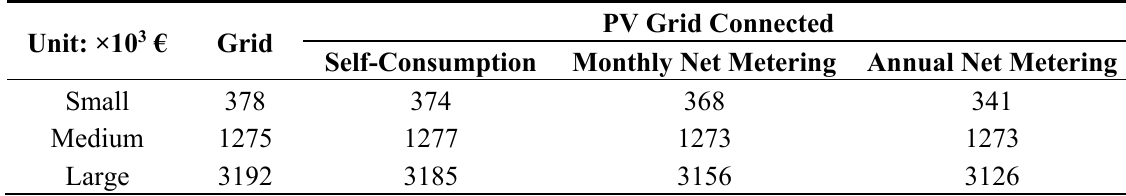
Table 7. Net present value (NPC).